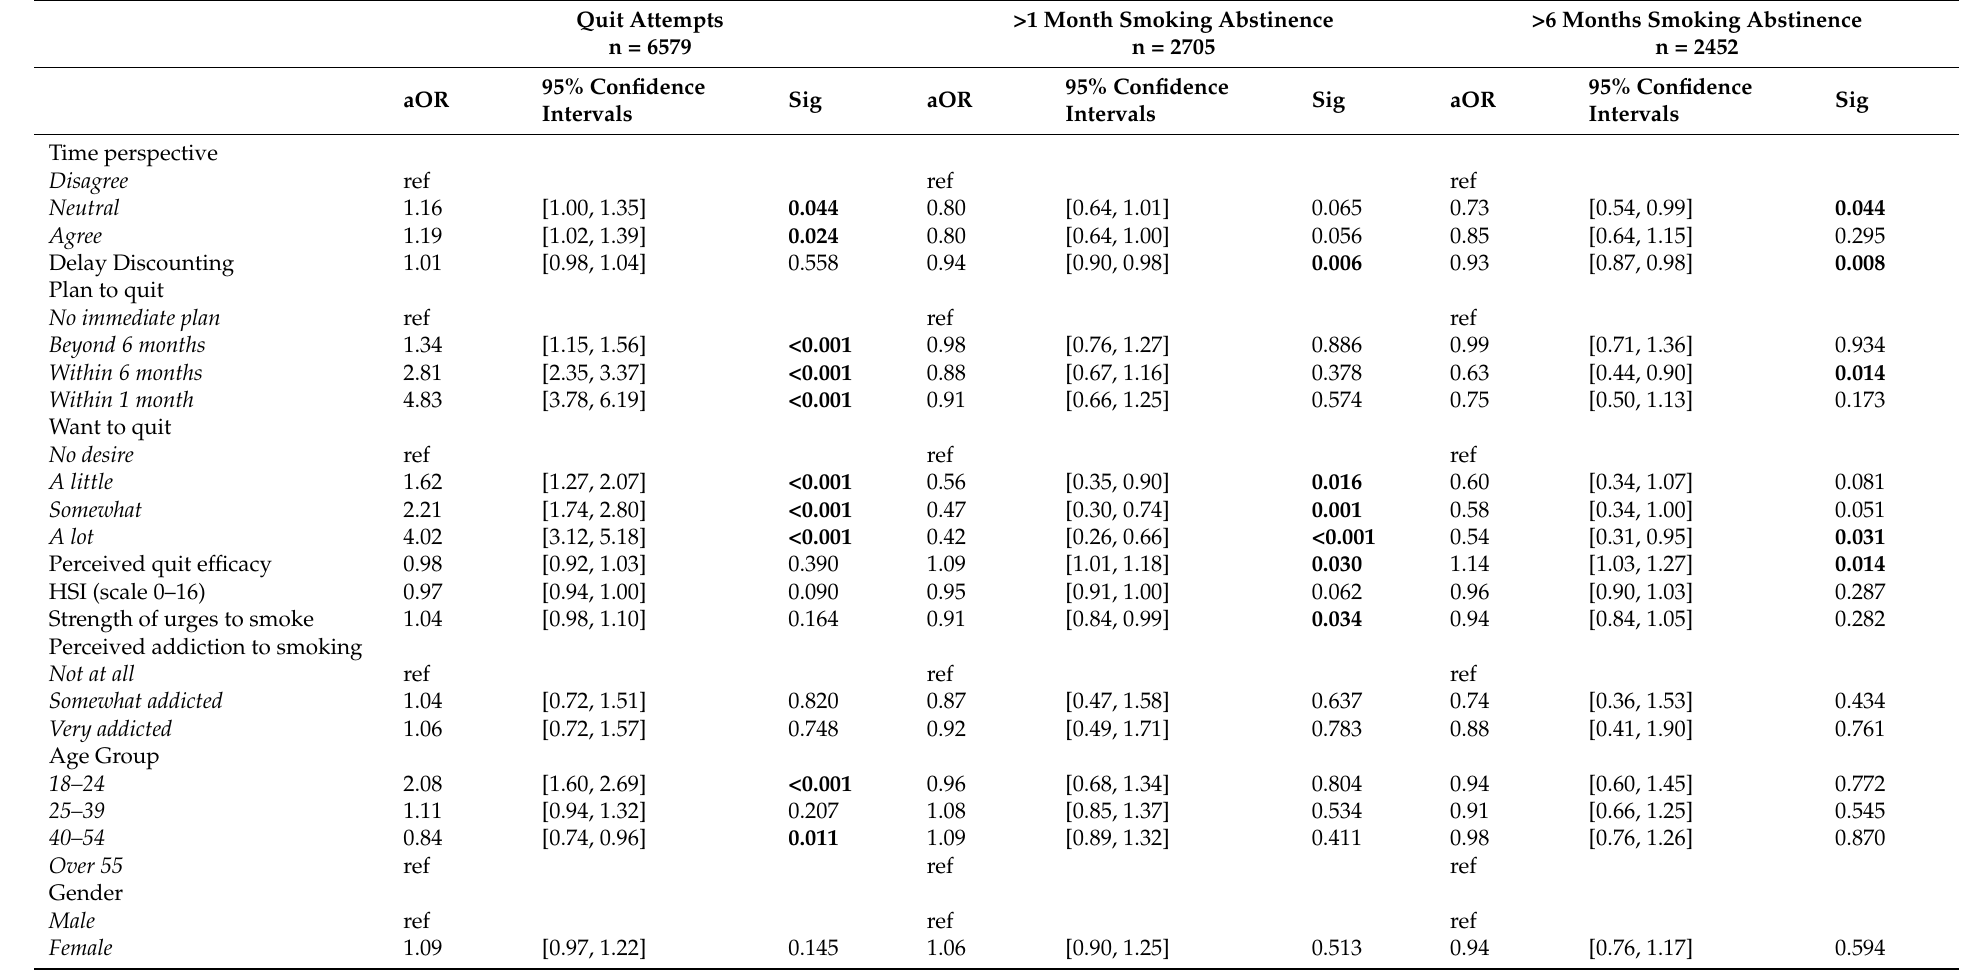
Table 2. Generalized estimating equations (GEE) showing probability of quit attempts and for >1 month and ≥ 6 months quit success as function of delay discounting, time perspective, motivational, demographic and dependence measure